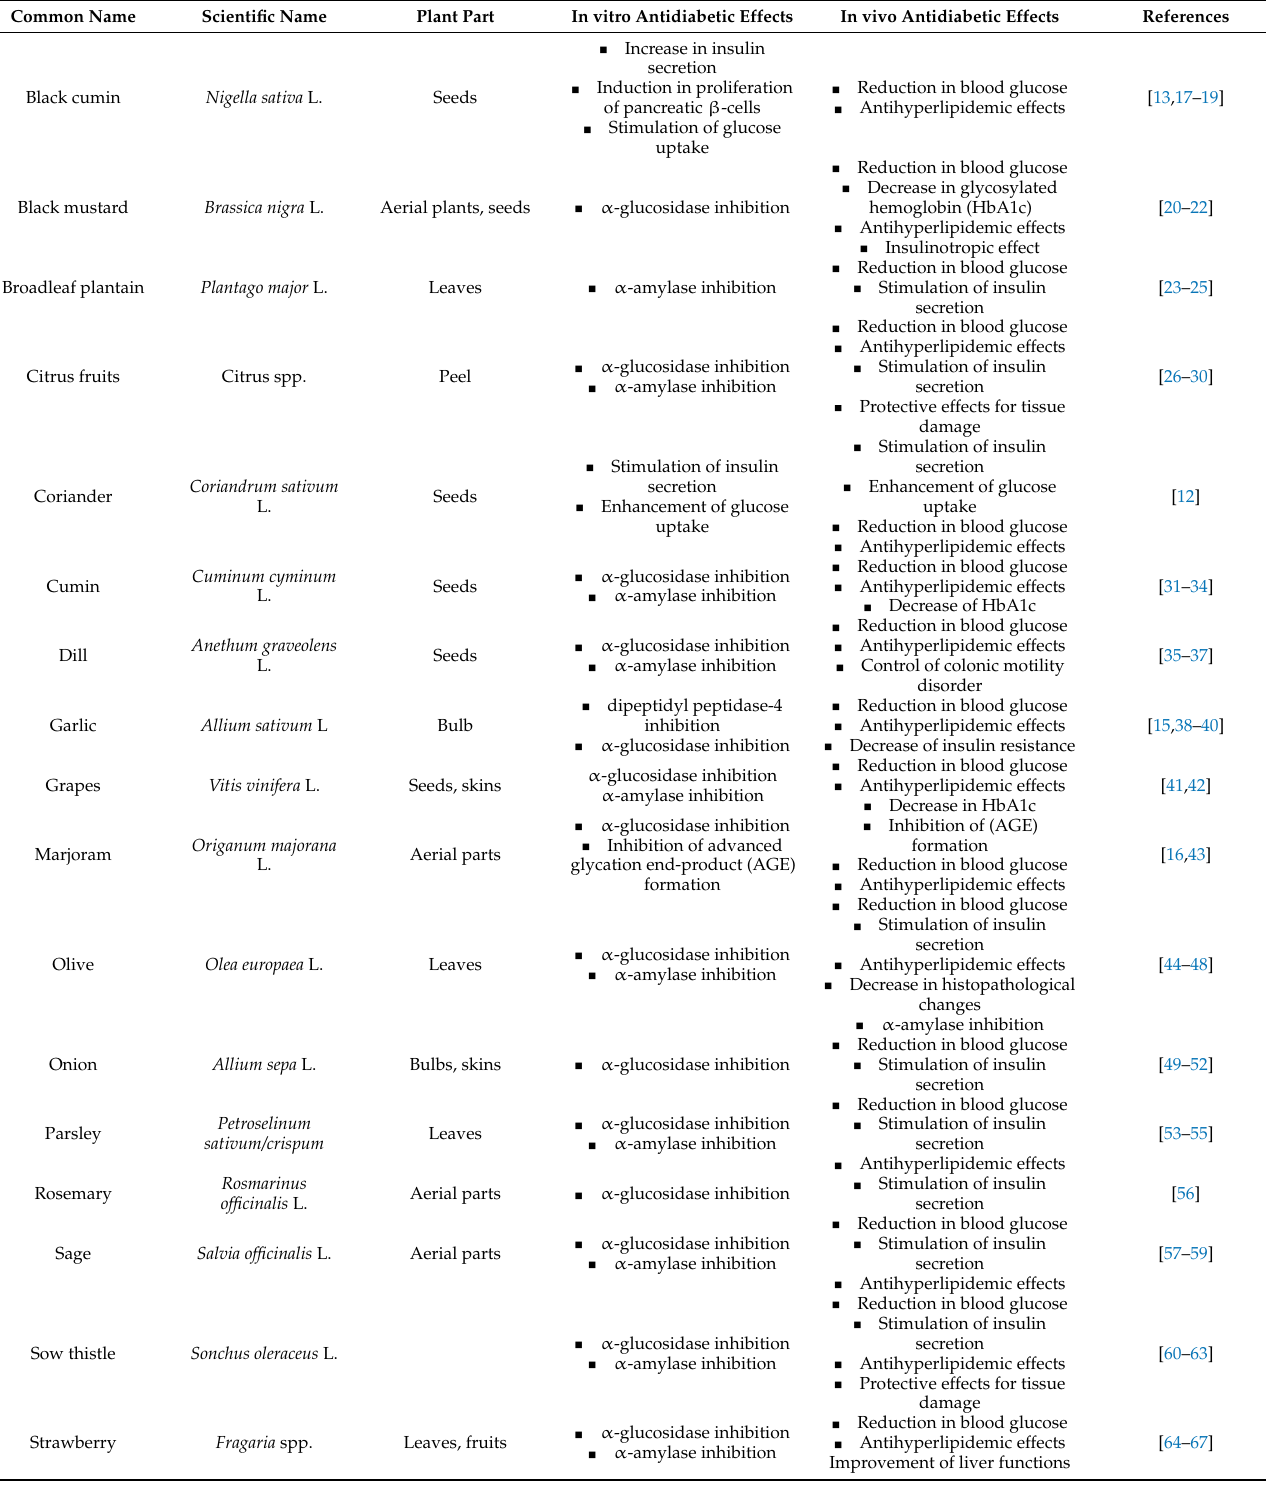
Brassica nigra L.